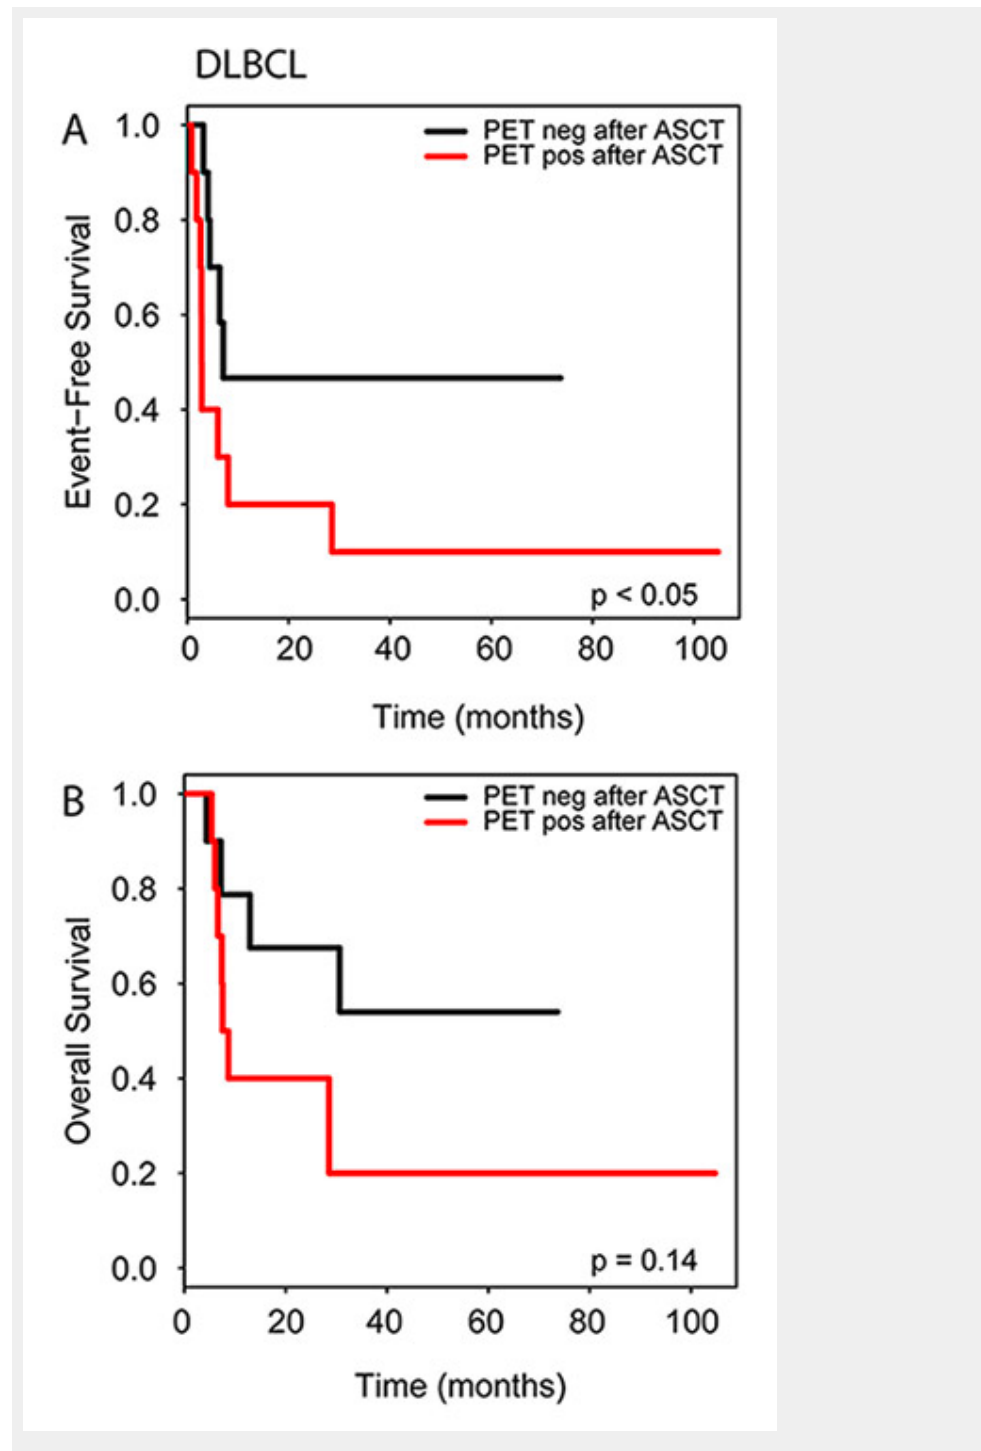
Figure 6 Impact of post-transplantation PET/CT on event free survival (A) and overall survival (B) in DLBCL